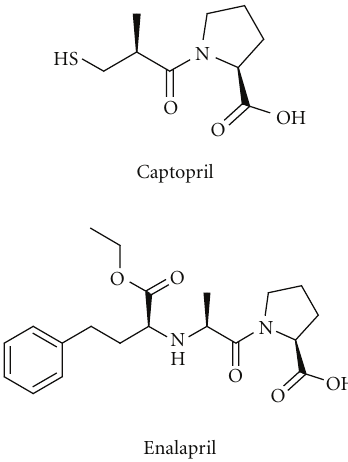
Figure 2: Captopril and enalapril, inhibitors of the angiotensin converting enzyme (ACE).